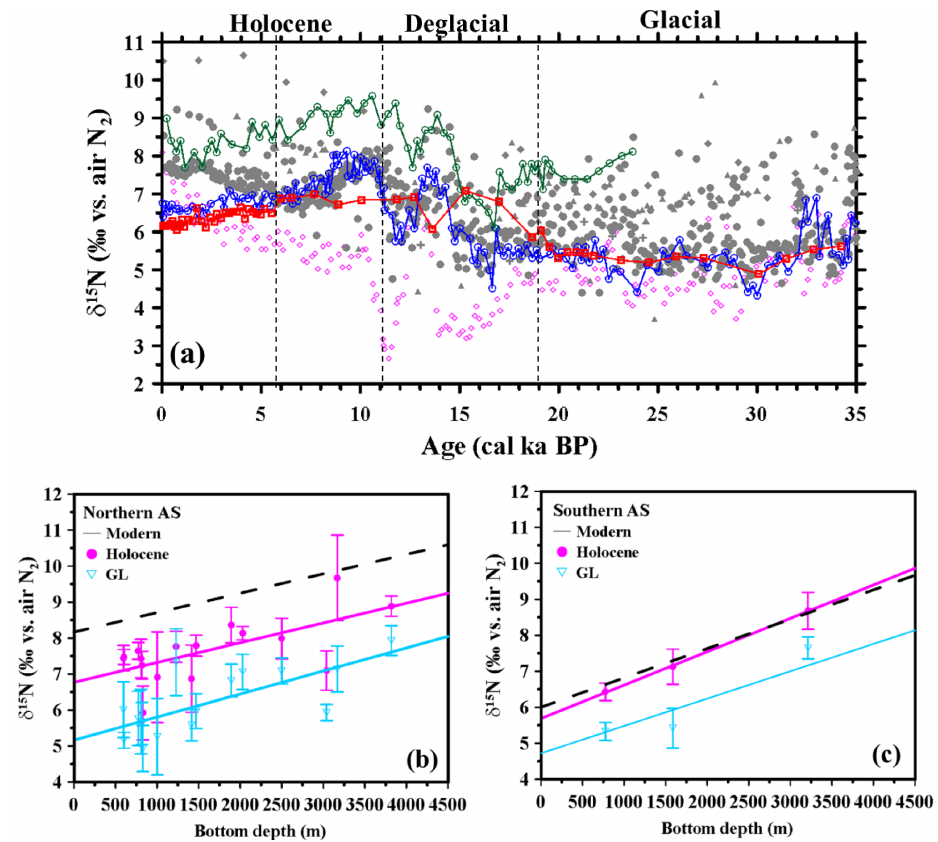
Figure 8. (a) Temporal variations of non-corrected δ 15 N bulk values of all reported cores in the AS. Data shown in curves are for cores in the southern Arabian Sea (red for SK177/11, blue for NIOP 905 and green for SO42-74KL), dots in gray are for the northern part and pink dots are for core MD-04-2876. Mean values of δ 15 N for fixed periods against corresponding water depths for cores in the (b) northern and (c) southern Arabian Sea. Pink and indigo blue are for the Holocene and glacial periods, respectively. Error bars represent the standard deviation for mean δ 15 N bulk .The dashed regression lines for modern surface sediments are shown for